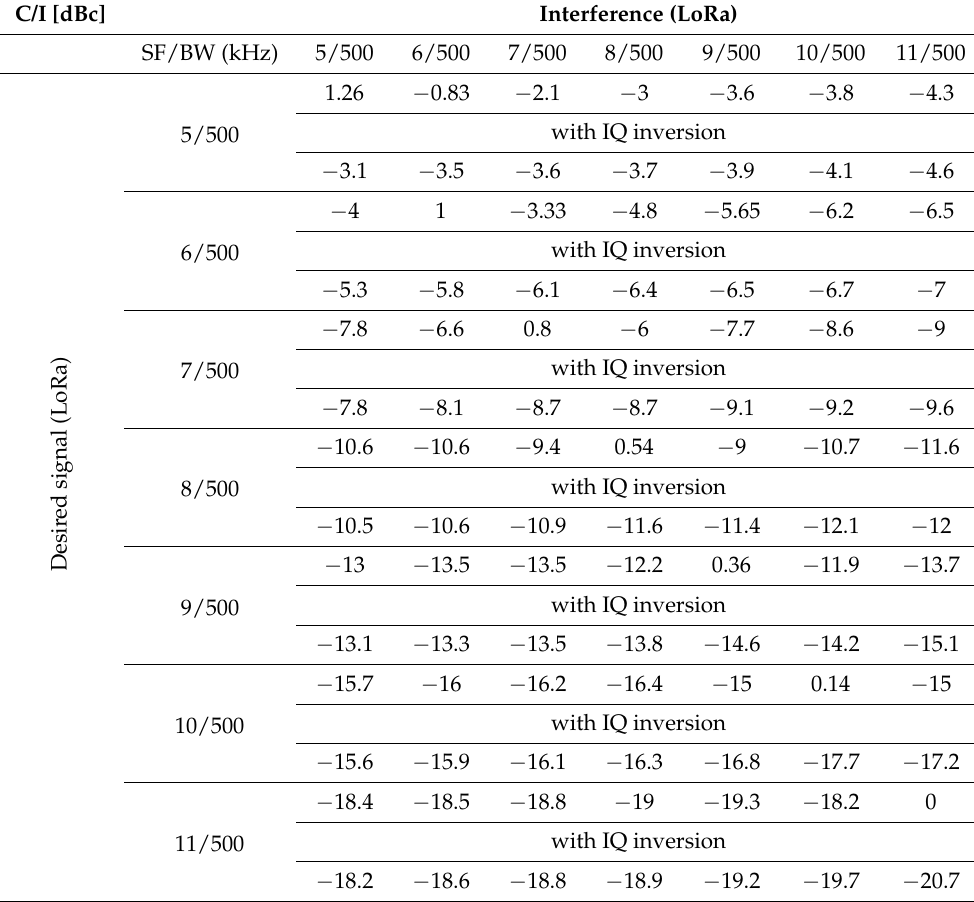
Table 2. C/I (SIR) results versus SF at BER = 10 − 4 with 500 kHz bandwidth with 64 bytes